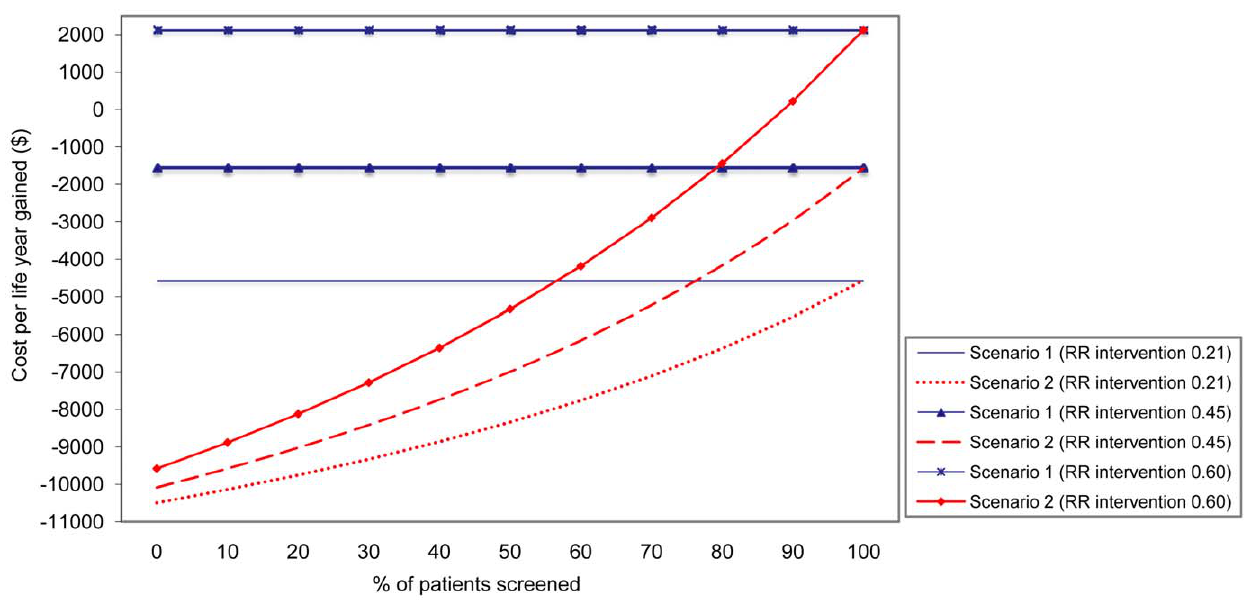
Figure 3. Effect of suboptimal adherence to preoperative S.aureus screening and treatment effectiveness on cost per life year gained (discounted) per 1000 patients for different screening scenarios. Scenario 1 is treatment of S. aureus carriers identified by screening; scenario 2 is treatment of S. aureus carriers identified by screening plus treatment of all patients that were not screened. In scenario 1 the life years gained and costs increase, or decrease, at a constant rate resulting in an invariable cost per life years gained. Note the negative costs on the y-axis representing cost-savings.